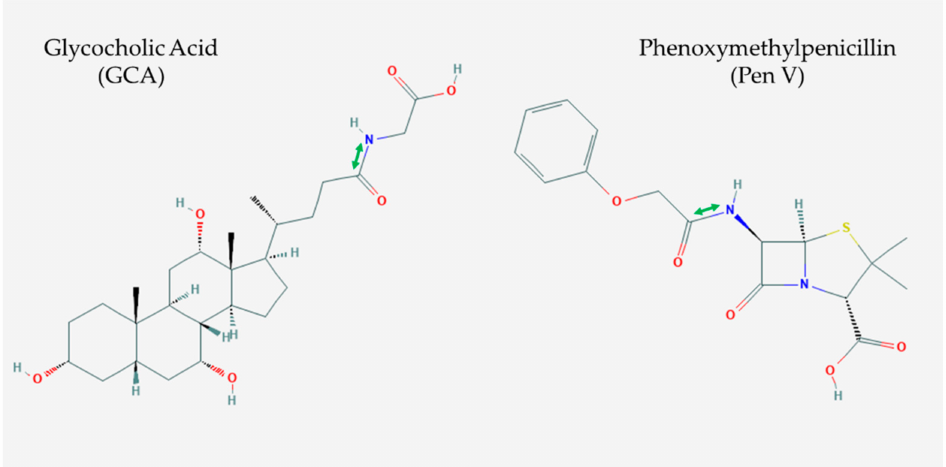
Figure 1. The 2-dimensional chemical structure of glycocholic acid (GCA) (PubChem identifier: 10140) and phenoxymethylpenicillin (Pen V) (PubChem identifier: 6869). The amide bonds hydrolysed by either bile salt hydrolase (BSH) or penicillin V acylase (PVA) are annotated by the green